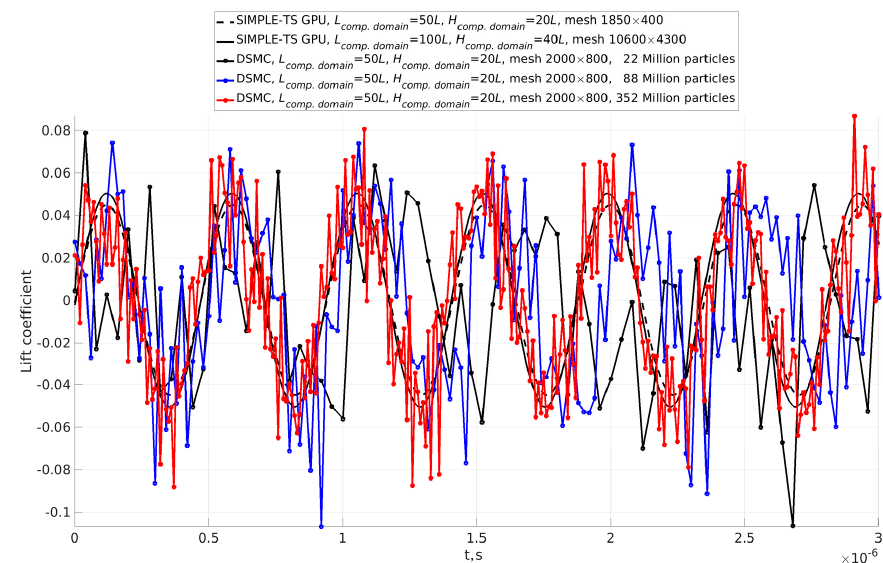
Figure 3. Comparison of convergence of time series of lift coefficients at established regime obtained by continuum approach (SIMPLE-TS) and DSMC.